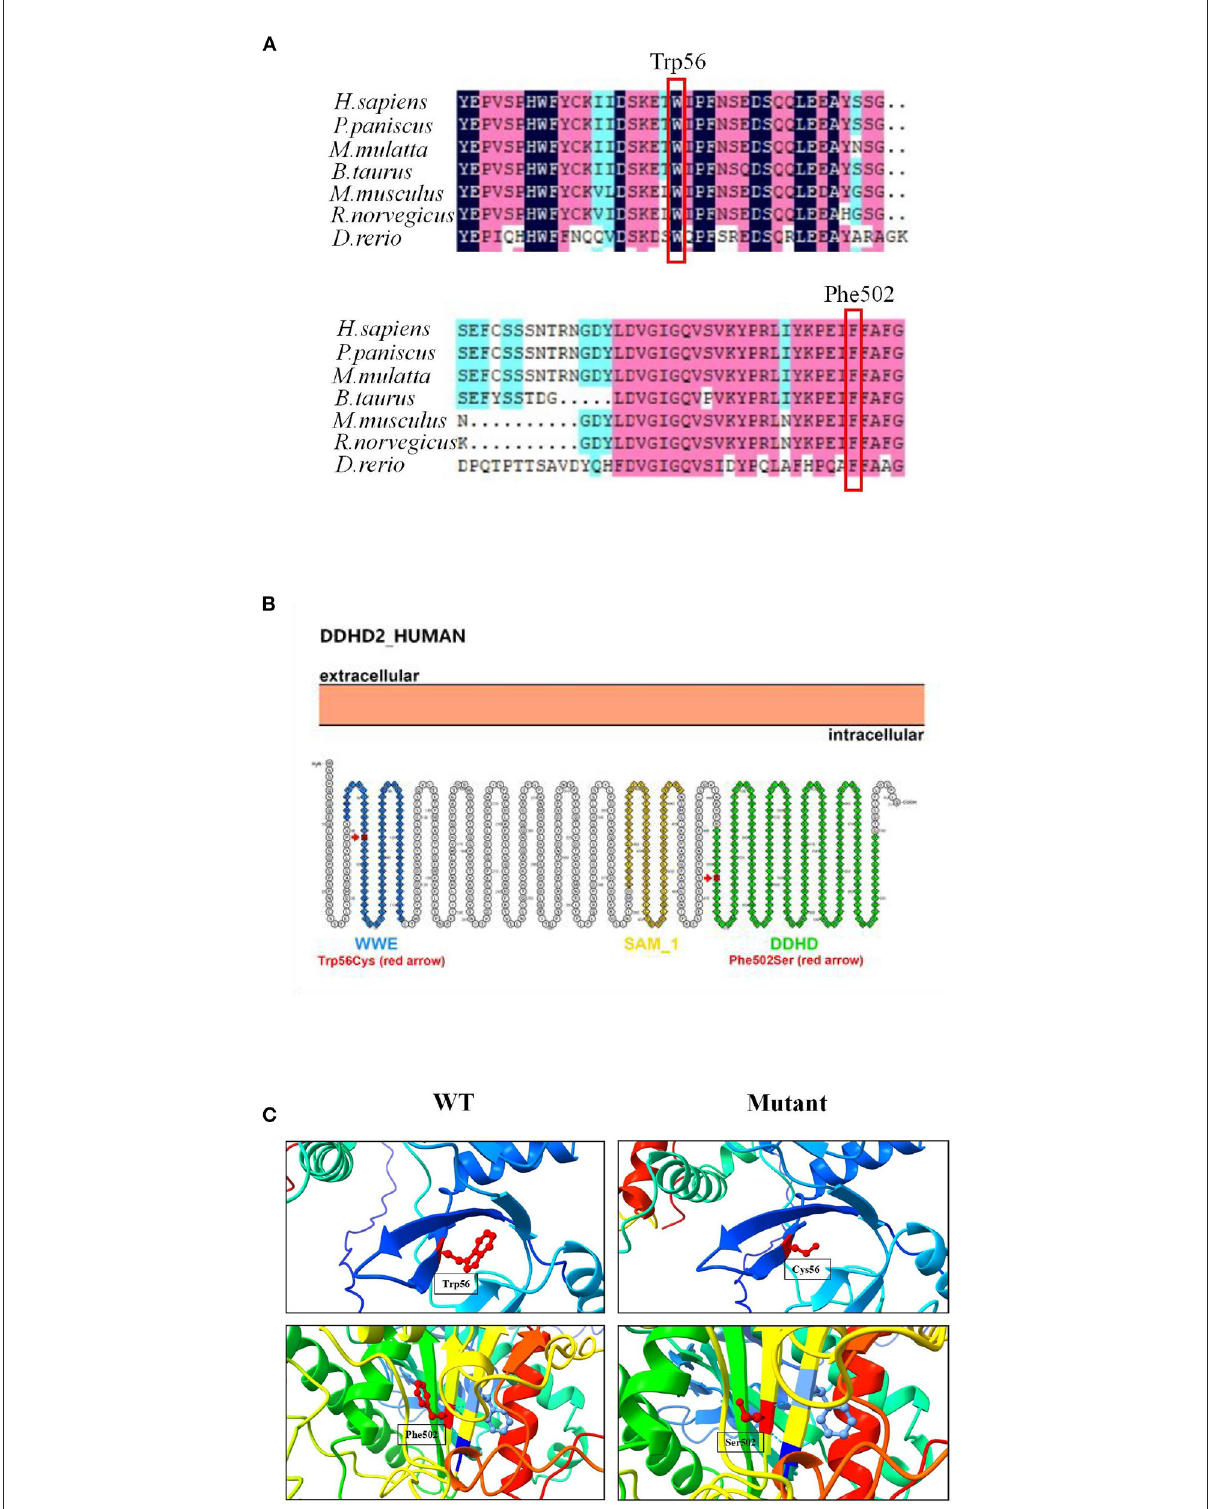
FIGURE3 Mutation analysis of DDHD2 . (A) Amino acid sequence alignment of DDHD2 from different species. Mutant amino acids 56 (tryptophan) and 502 (phenylalanine) are highly conserved across species. (B) Secondary structure diagram of DDHD2 protein. The p.Trp56Cys mutation located in the WWE domain and the p.Phe502Ser mutation located in the DDHD2 domain. (C) Protein molecular models of wild type (WT) and mutant DDHD2 protein